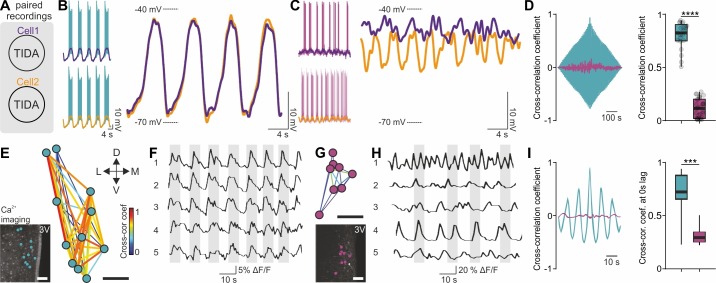
Synchronous vs asynchronous activity in TIDA neurons between two rodent species.(A) Paired whole-cell recordings were performed to test synchronous activity between cells. (B) Representative paired rat TIDA neuron recordings (left) shown superimposed and filtered for action potentials at right to reveal near identical membrane voltage fluctuations. (C) Representative paired mouse TIDA neuron recordings (left) reveal asynchronicity when superimposed (right). (D) Left; cross-correlation coefficient in example paired recordings from rat (blue) and mouse (purple) TIDA neurons. Right; quantification of cross-correlation coefficient at 0 s lag (n = 21–31 respectively, p<0.0001, unpaired t-test). (E) Ca2+ imaging of rat TIDA neurons. Lower inset: oscillating cells in the dmArc slice shown highly connected by relative cross-correlation. (F) Representative Ca2+ imaging traces of five rat TIDA neurons in same slice revealing synchronous oscillations. (G) Ca2+ imaging of mouse TIDA neurons. Lower inset: Cells in the dmArc in the same slice exhibit minimal cross-correlation. (H) Representative Ca2+ imaging traces of five mouse TIDA neurons in same slice revealing asynchronous oscillation. (I) Left; cross-correlation coefficient in rat (blue) Ca2+ imaging traces vs cross-correlation coefficient in mouse (purple) TIDA neurons. Right; quantification of cross correlation coefficient at 0 s lag (n = 14–21 respectively). Data expressed as mean ±s.e.m. Image scale bars (E G) 50 μm. 3V, third ventricle.